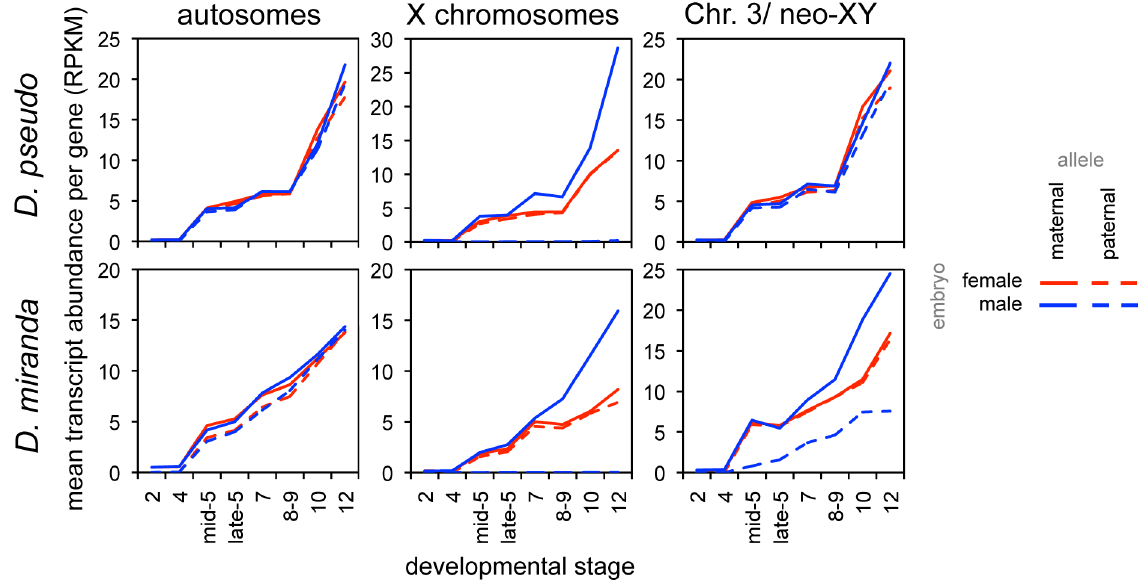
Figure 5. Onset of dosage compensation for zygotically transcribed genes, as revealed by allele-specific expression. Mean proportion of reads per gene attributable to the maternal and paternal alleles, in both female and male embryos, for zygotic genes (defined by transcript level, see Methods). While there are no significant differences in transcript level from the autosomes, the single male X begins to be transcribed at a higher level than either female X, resulting in compensation of chromosome dosage. Unlike D. melanogaster [15], these two species show several stages of zygotic expression with the male X having the same transcript abundance as the female Xs, indicating a period with, on average, no dosage compensation (the D. melanogaster study was of a tighter distribution of stages, and ended at late stage